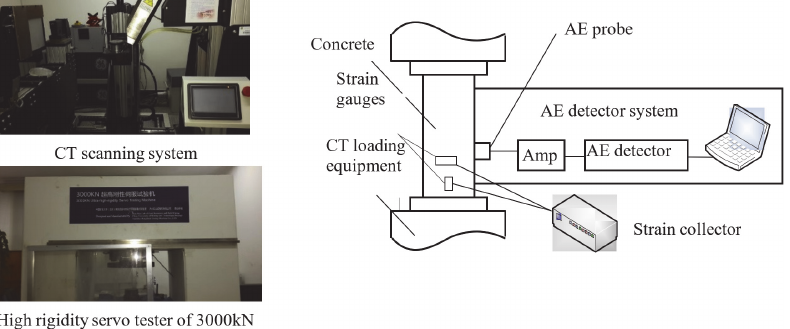
Figure 1: Sketch of experimental system.